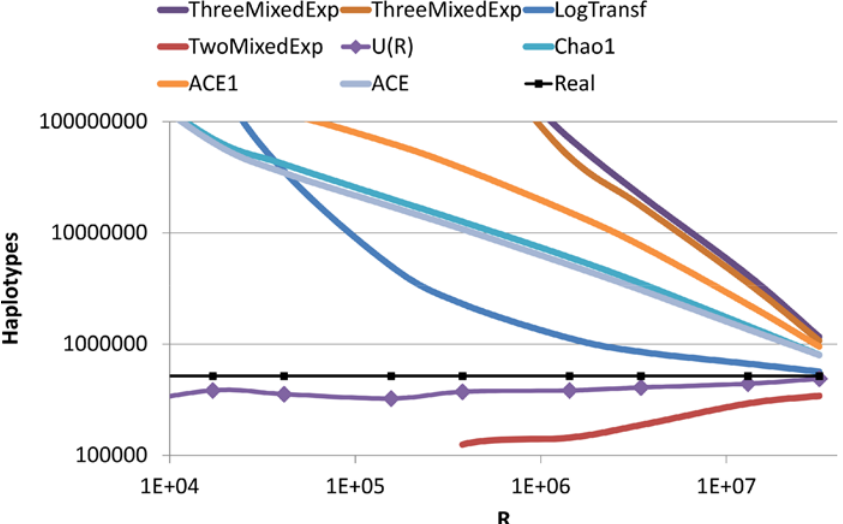
Fig 3. Comparisons of methods to evaluate the haplotype number. We compare the Bunge and Barger (2008) method as implemented in the Catchall model using a population with scale free frequency distribution of haplotypes with a slope of -1.5 and compare the estimated species richness as supplied by the Catchall software for all models where the software converges to a result. These models include parametric predictions procedures, such as Mixture-of-two-exponentials-mixed Poisson and Mixture-of-three- exponentials-mixed Poisson on the observed species richness or on their log values and non-parametric procedures, such as the ACE (Abundance-based Coverage Estimator) ACE1 (Abundance-based Coverage Estimator for highly heterogeneous cases) and different versions of the Chao-Bunge gamma-Poisson estimator. Each line represents the estimated number of haplotypes using one of the Catchall methods. The black line represents the real simulated species number. The purple line with diamonds represents our estimates. Our estimates converge much faster and to a much more precise estimate of the real haplotype number than any of the methods proposed by Catchall.